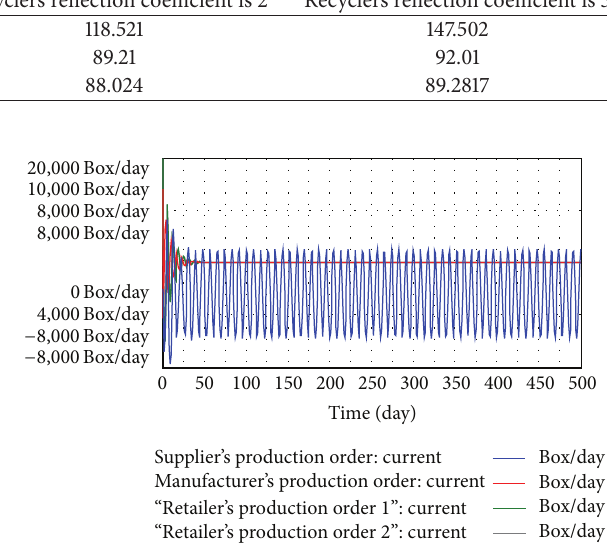
Figure 11: Changes of the order quantity of each member when recycled product delay time is 42.